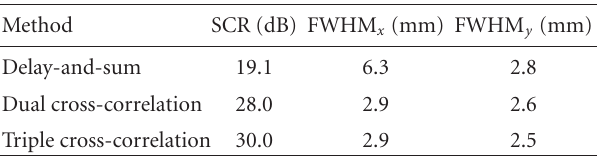
Table 1: FWHM and SCR for di ff erent imaging methods in numerical test